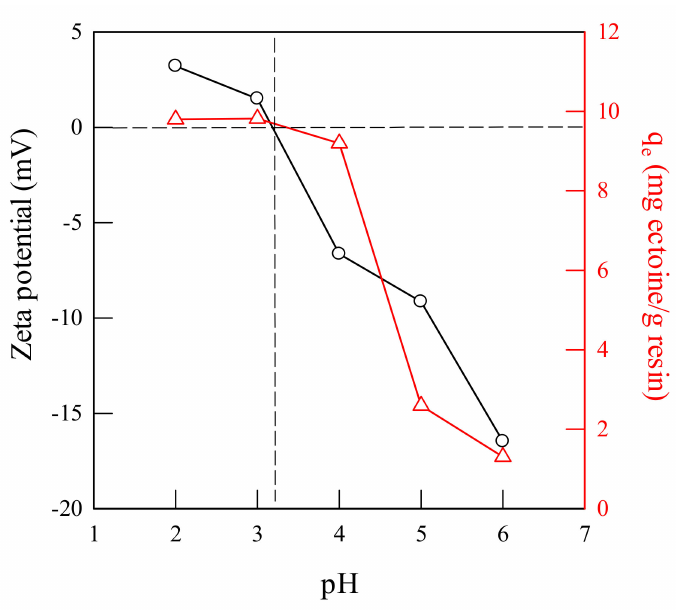
Figure 3. Plot of ectoine’s zeta potential and adsorption capacity of ectoine on pH (Dowex ® HCR-S resin/aqueous = 0.1 g/mL).